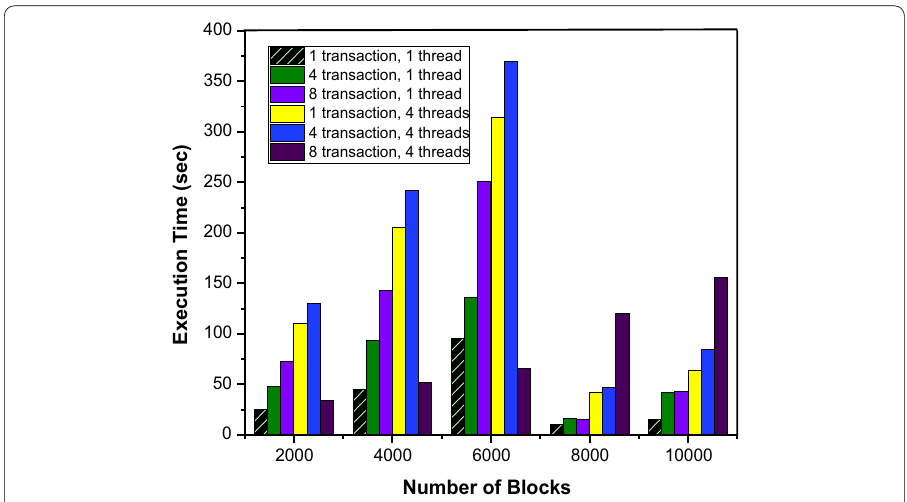
Fig. 6 Performance time of the chain authentication process. One vital experimental outcome is that the chain authentication method was achieved quicker and consumes a lesser amount of energy when connections are clustered in a block. This figure represents when there are four or eight connections clustered in one block, the total processing time per block can be diminished roughly 35–50%